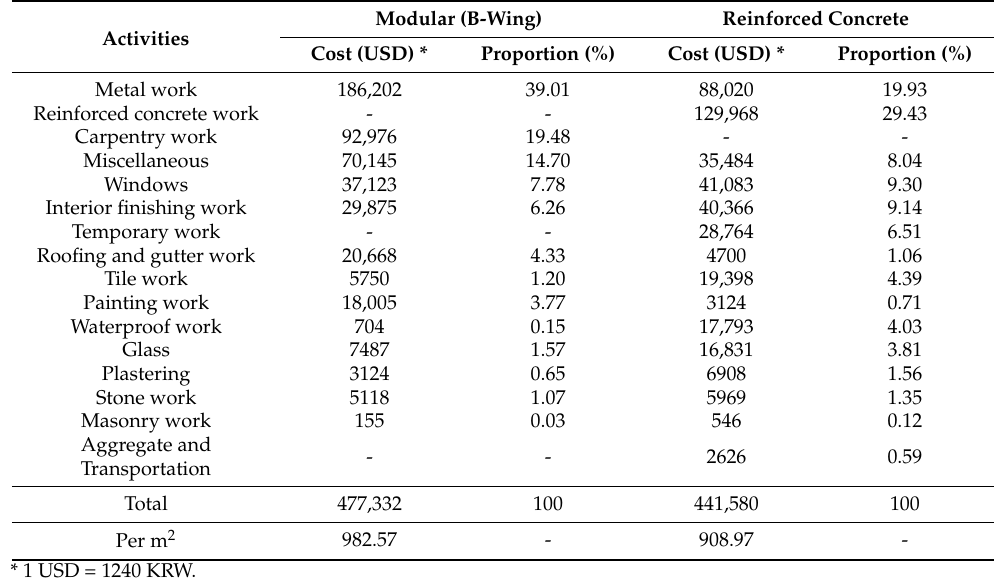
Table 6. Direct construction costs for the modular and RC construction methods.